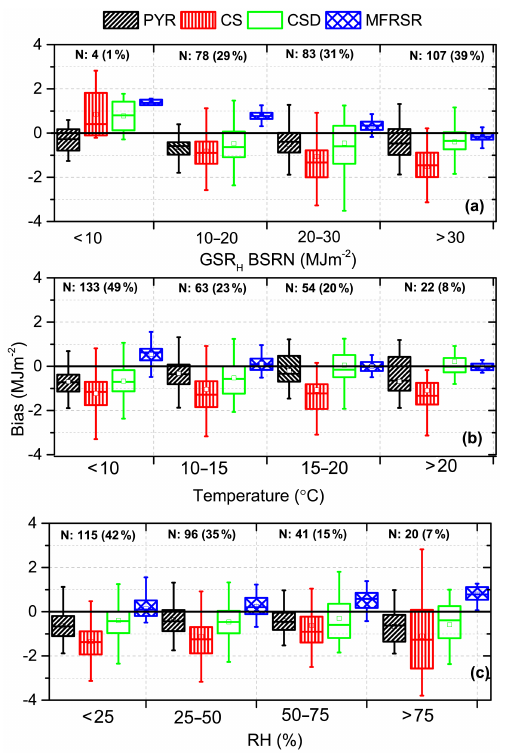
Figure 3. Box plot of bias (PYR: black; CS: red; CSD: green; and MFRSR: blue) versus (a) corresponding BSRN GSR H measure- ments (MJm − 2 ), (b) temperature in ◦ C and (c) relative humidity (RH) in % between 17 July 2014 and 12 July 2015 at IZO. Lower and upper boundaries for each box are the 25th and 75th percentiles, the solid line is the median value, and hyphens are the maximum and minimum values. N indicates the number the measurements in each